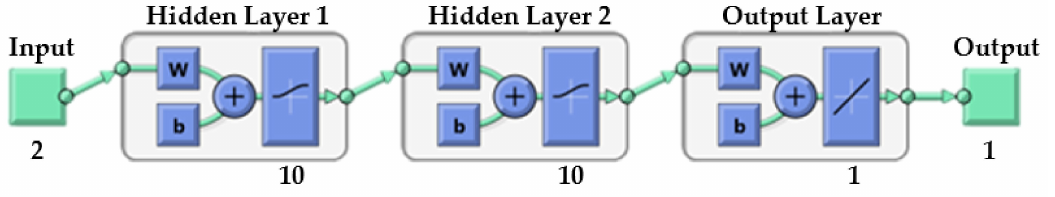
Figure 6. Topology of the best-selected